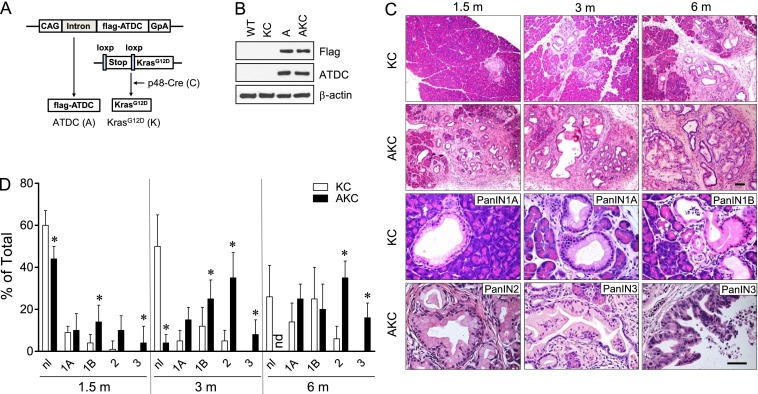
ATDC accelerates PanIN progression in KC mice. (A) Schematic of the ATDC TG construct used to generate CAG-ATDC mice. (A) ATDC; (K) LGL-KrasG12D; (C) p48-Cre; (CAG) CAG promoter; (GpA) β-globin polyA. (B) Representative Western blot using Flag and ATDC antibodies showing ATDC transgene expression in ATDC (A) and AKC (ATDC; LGL-KrasG12D; p48-Cre) mice but not in wild-type (WT) and KC (LGL-KrasG12D; p48-Cre) mice. (C) Representative images of PanIN lesions in 1.5-, 3- and 6-mo-old KC or AKC mice. Bars: top panel, 100 µm; bottom panel, 50 µm. (D) Quantification of PanIN lesions at the indicated time points in KC or AKC mice. Percentages (±SEM) of normal (nl) and PanINs by grade (1A, 1B, 2, 3) in mice at 1.5 mo (n = 12), 3 mo (n = 15), and 9 mo (n = 15) of age. (*) P < 0.05 versus KC. (nd) Not detected.